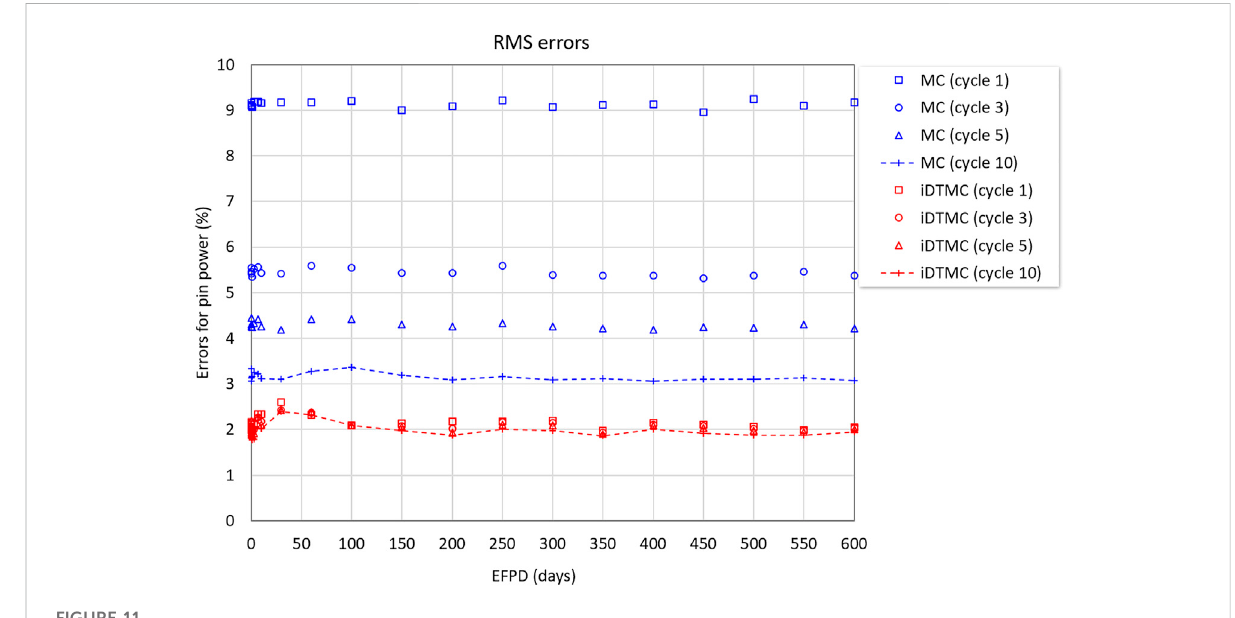
FIGURE 11 Cycle-wise RMS errors for the pin power pro fi le.